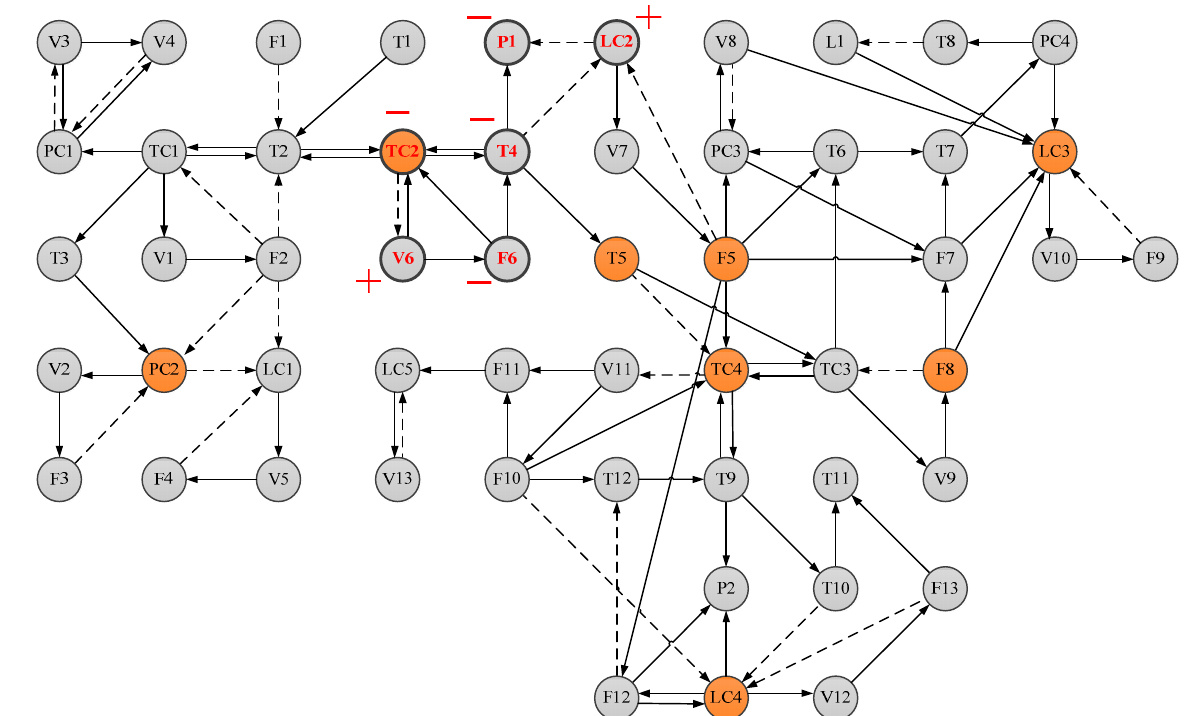
Figure 13. The SDG model of the fault situation.